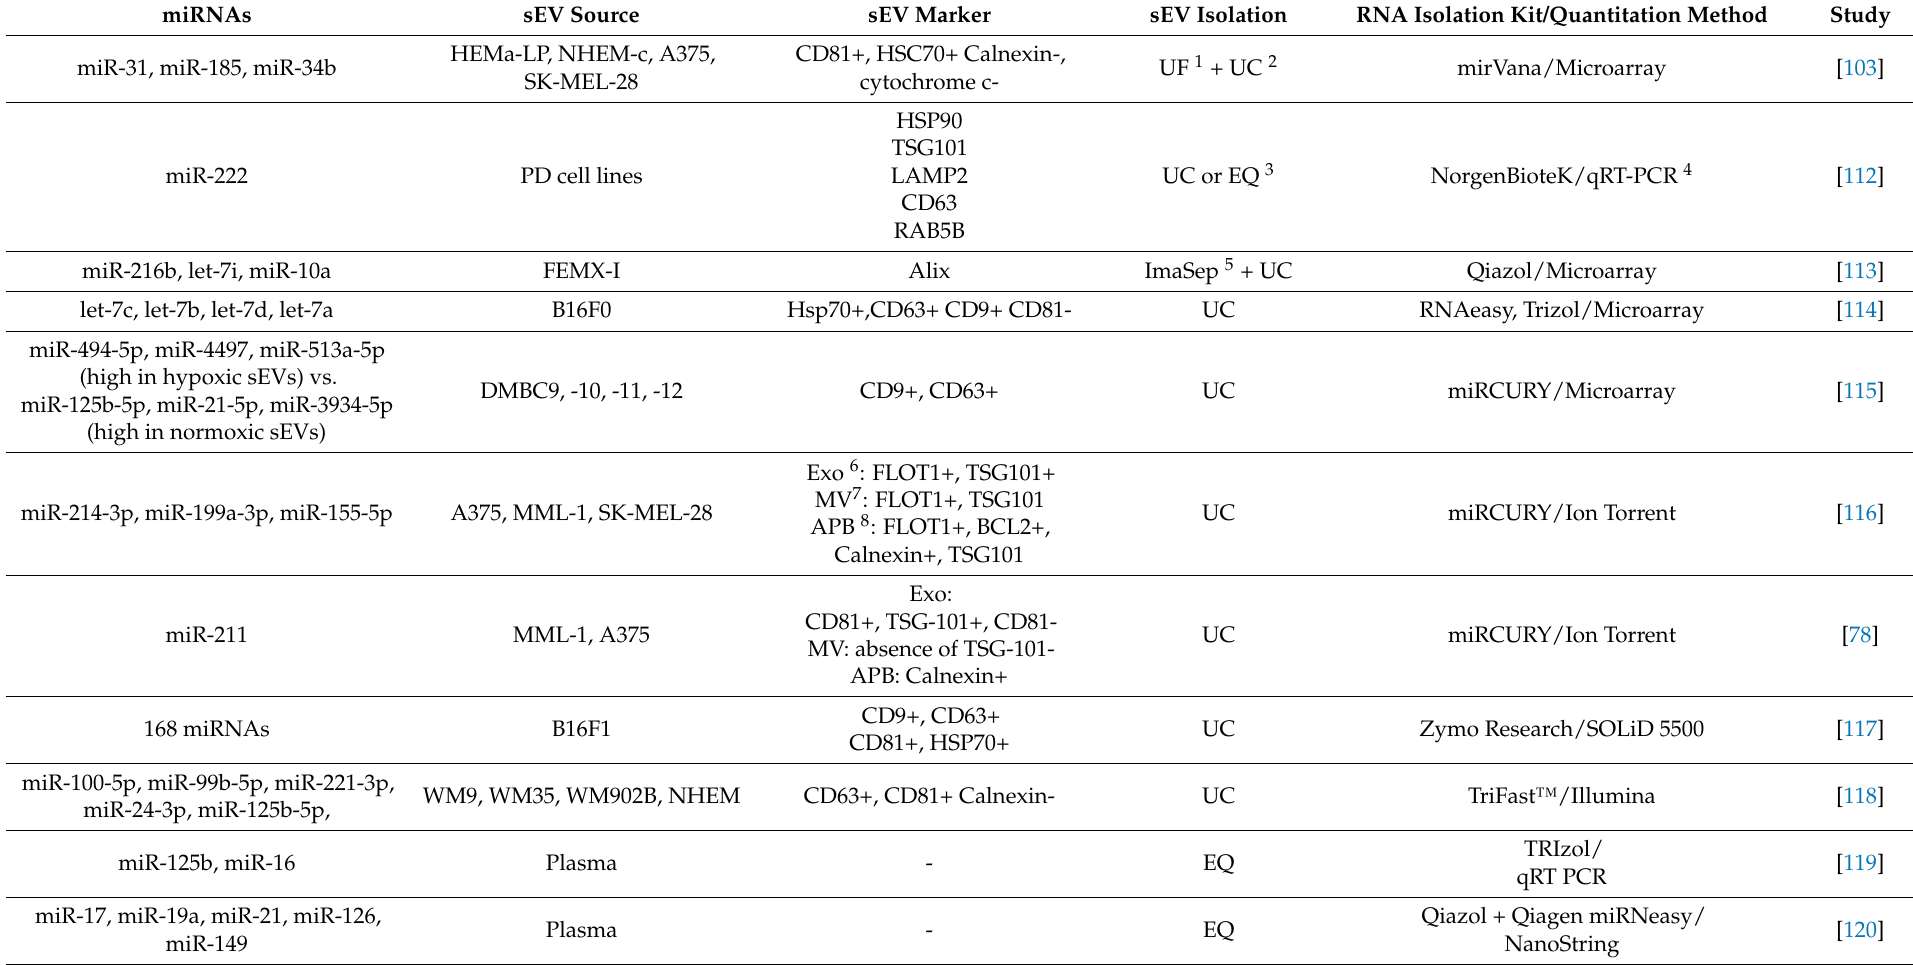
Table 1. Studies detecting sEV-derived miRNA implicated in melanoma